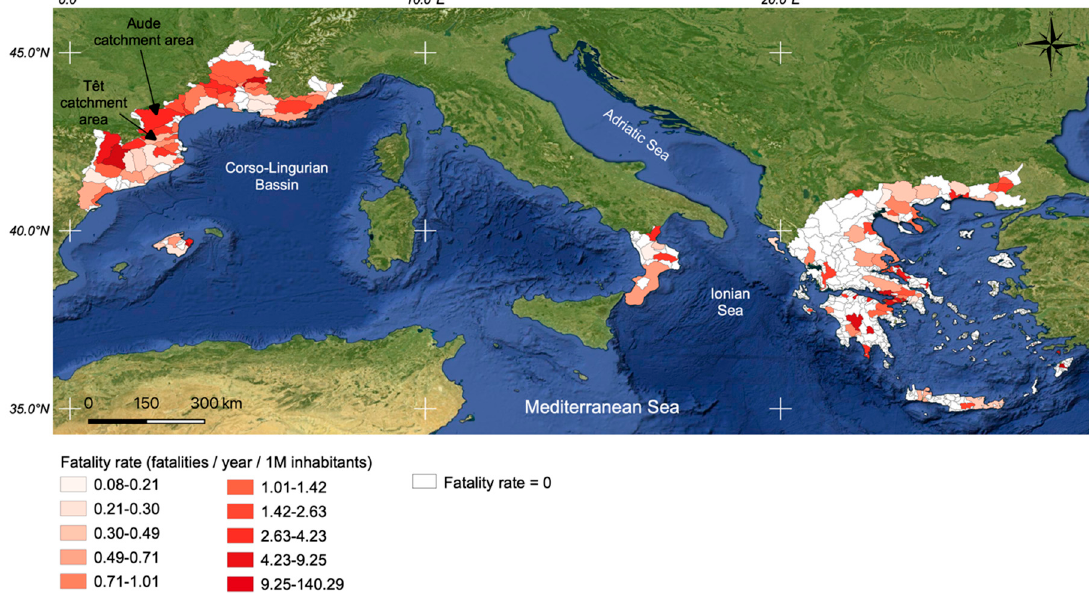
Figure 10. Fatality rate by catchments based on the decile classification excluding 0.00 values.